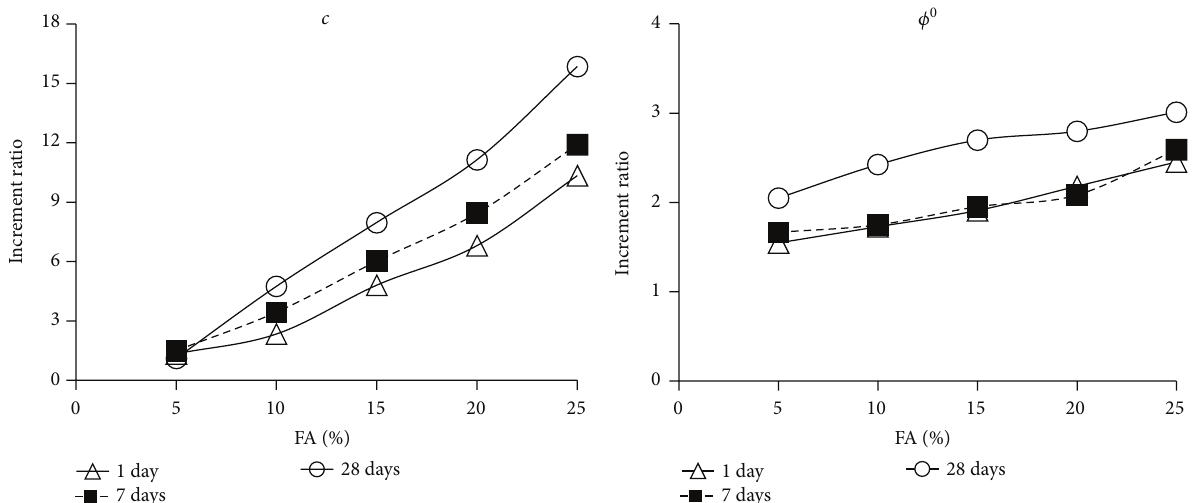
Figure 13: The increment ratios of shear strength parameters ( 𝑐 - 𝜙 ) with FA and curing